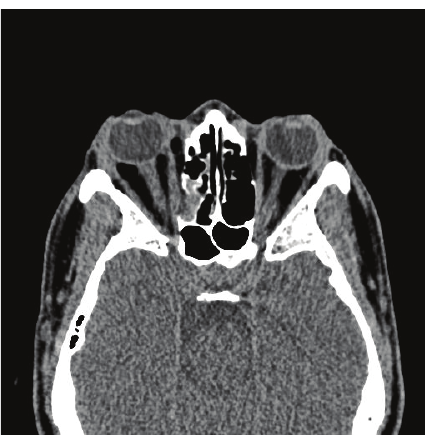
Figure 4: Medial orbital wall blowout injury with relief of tension orbit. It also shows more than half the gas has been resorbed and no definite evidence of optic sheath